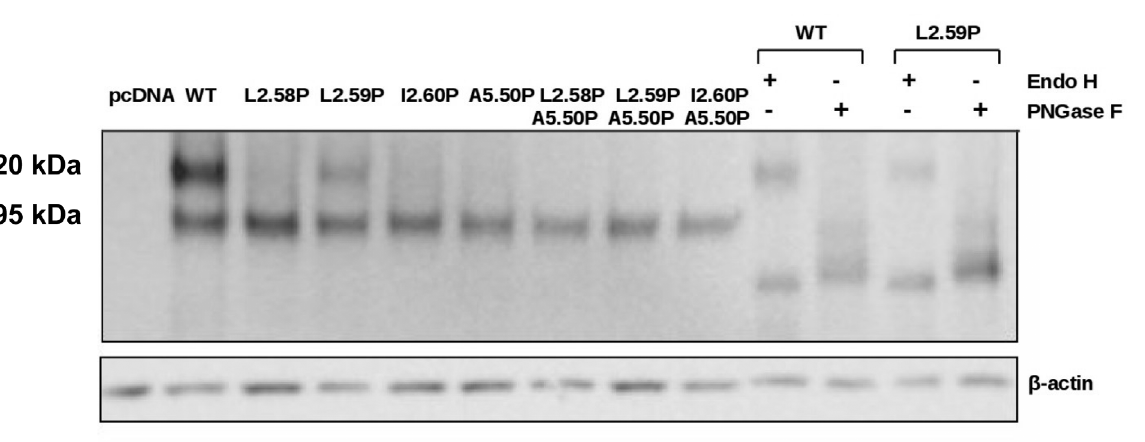
Fig 4. Glycosylation status of the TSHR mutants. Typical western blots of WT and mutated TSHRs, representative of three independent experiments. The identity of the bands was verified by treatment with endoH and PNGase. The band at 120 kDa corresponds to complex glycosylated receptors that are endoH resistant and PNGaseF-sensitive. The band at 95 kDa corresponds to high mannose-glycosylated receptors that are endoH and